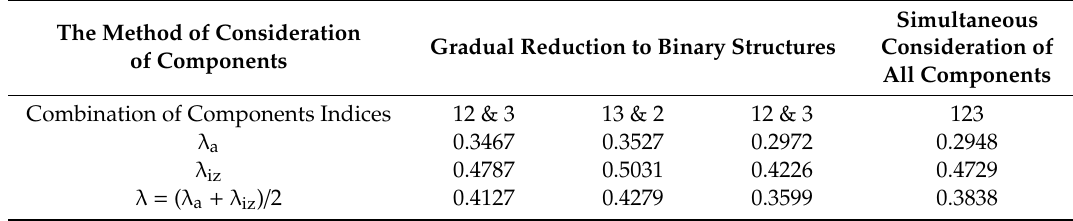
Table 1. Calculated values of thermal conductivity of a porous material with isolated liquid inclusions (a three-component system) at adiabatic and isothermal division of the unit cell and their arithmetic means determined on the basis of the two methods